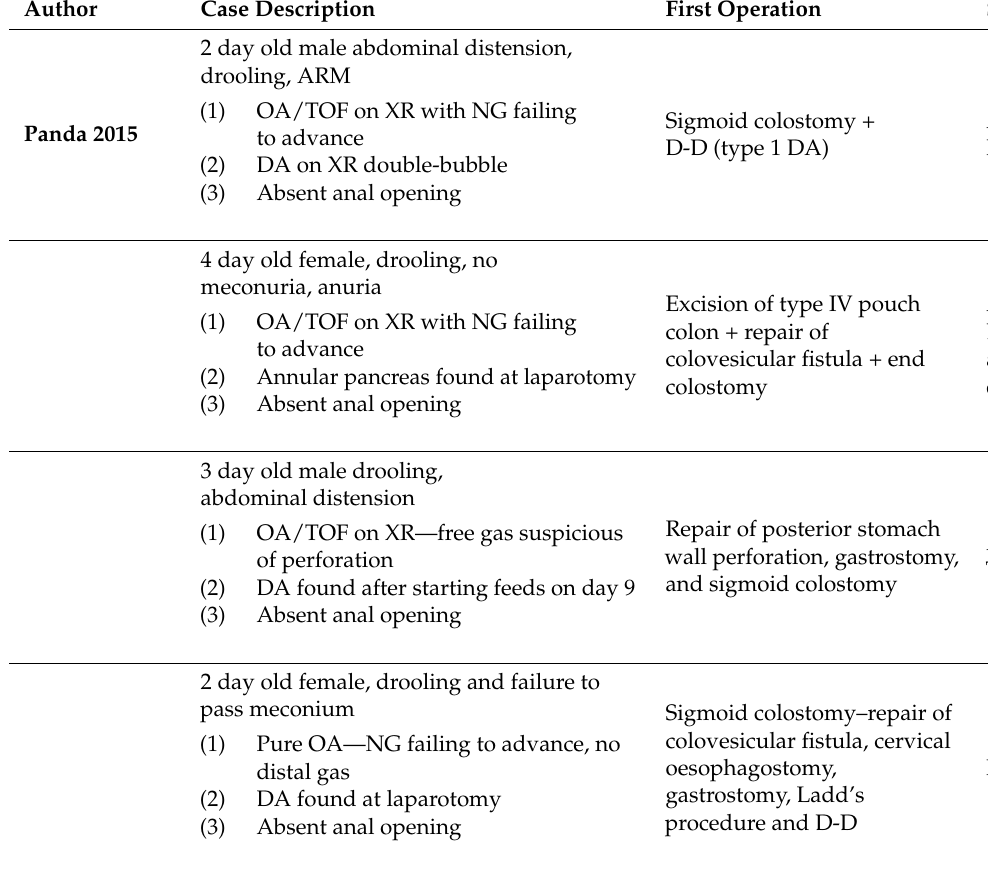
Table 1. Summary of literature